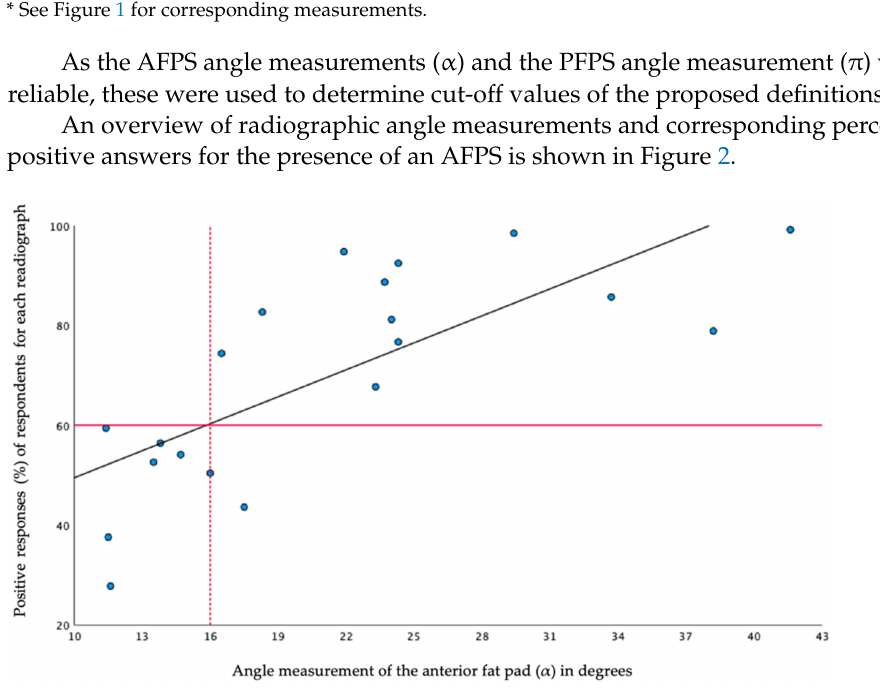
Figure 2. Scatter plot showing the mean angle measurements plotted against the percentages of positive respondents for the presence of an AFPS, assessed on the 20 radiographs. The horizontal red line indicates the 60% level of agreement of the respondents. The vertical dotted red line shows the mean angle at which at least 60% of the respondents indicated the presence of the